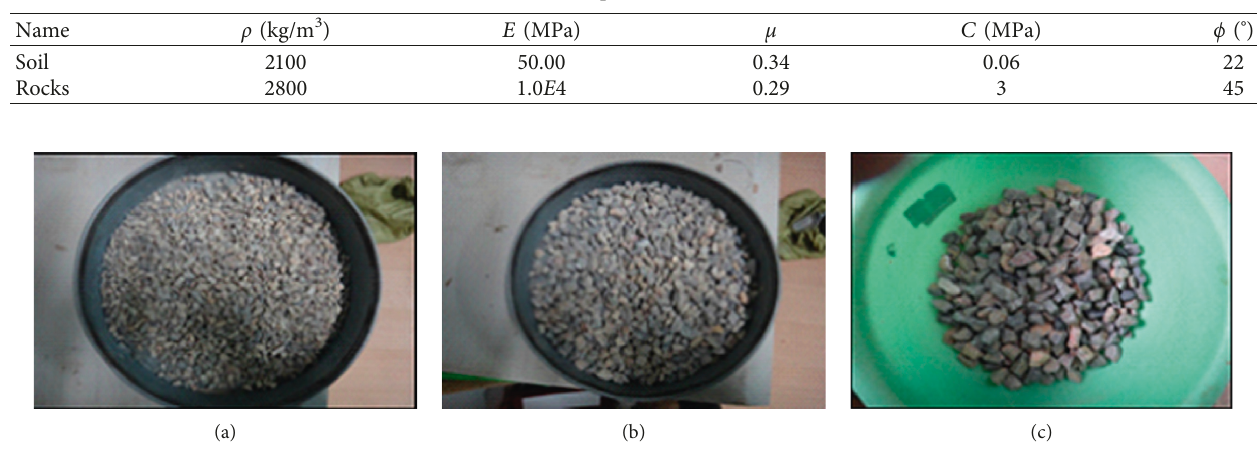
Table 2: Mechanical parameters of soil and